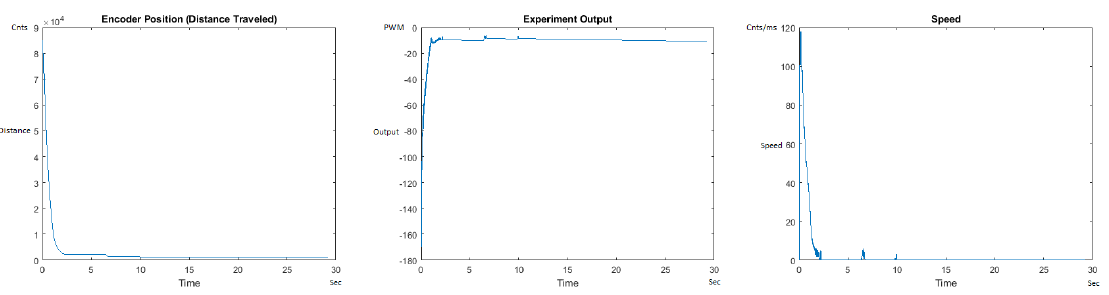
Figure 37. Encoder position, output and speed plots for basic PID DOWN operation—10 g.